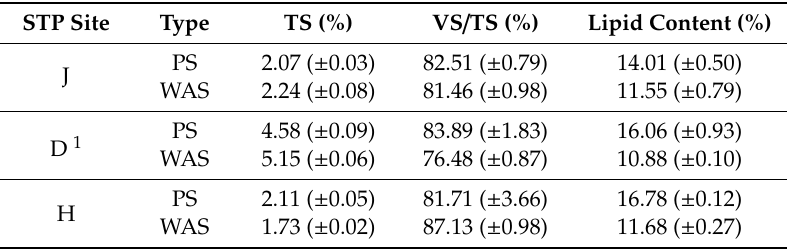
Table 2. Solid and lipid content of raw wastewater sludge for each STP. TS—total solids; VS—volatile solids; PS—primary sludge; WAS—waste activated